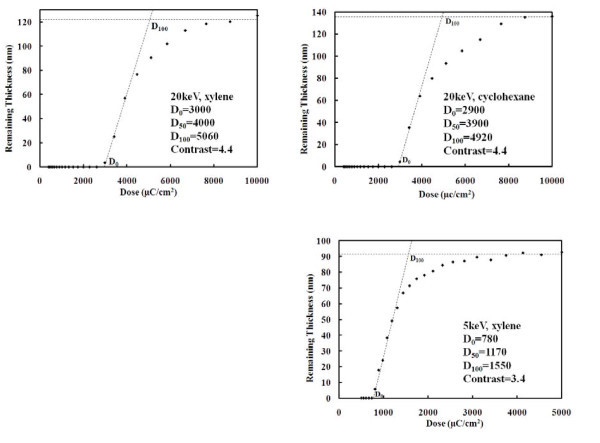
Contrast curves for polystyrene exposed at 20 and 5 keV, and developed by xylene and cyclohexane for 90 s at room temperature.